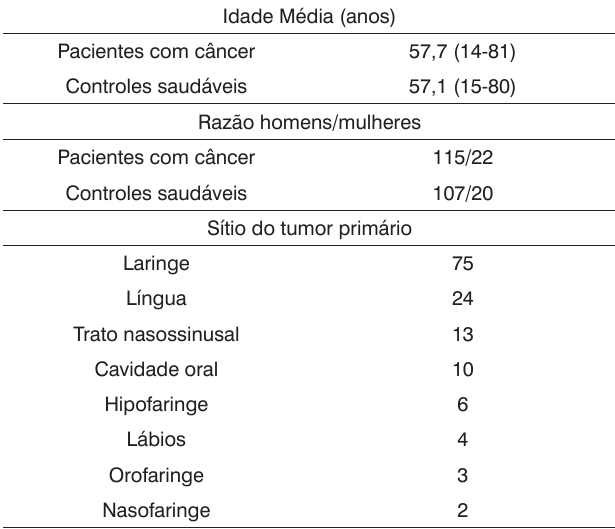
Tabela 1. Características dos